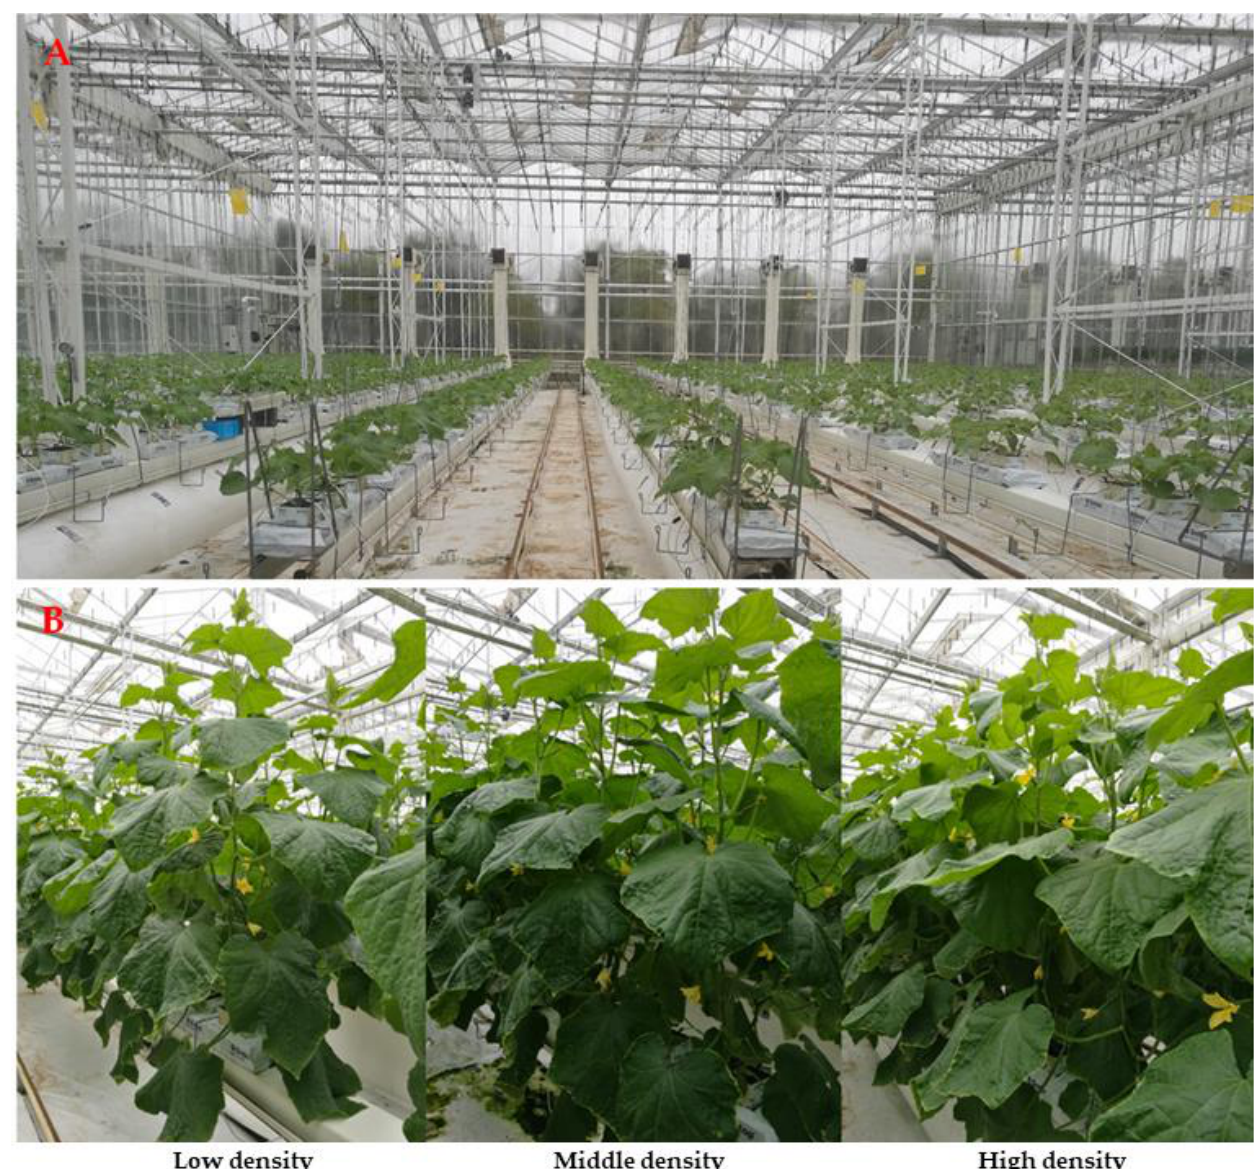
Figure 1. The cultivation arrangement of three density treatments in greenhouses. ( A ), the semi-closed, Venlo-type glass greenhouse used in the experiment. ( B ), picture of the plants, with about 15 leaves unfolding in different density